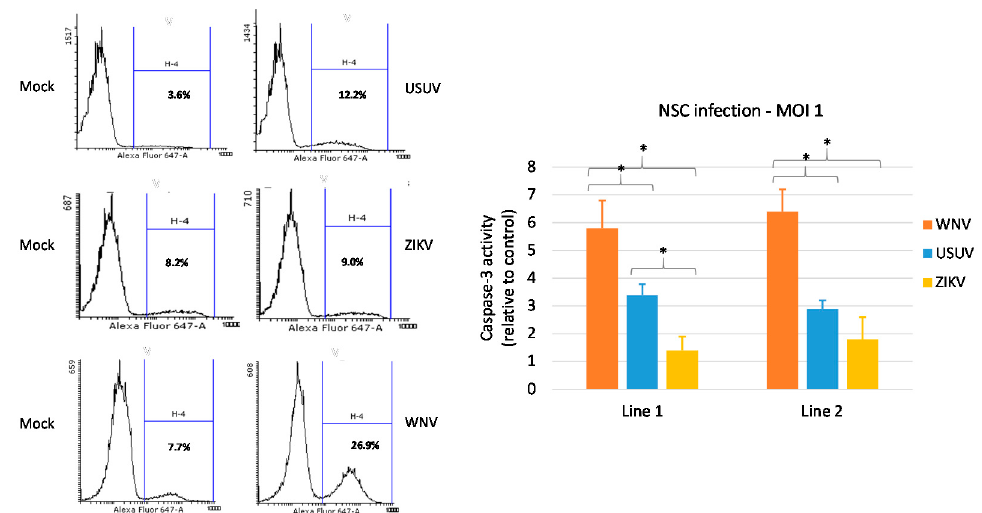
Figure 5. Effect of WNV, USUV and ZIKV infection on NSC apoptosis. Activated-caspase-3 was measured by flow cytometry in cells collected at 4 days post infection with WNV lineage 2, USUV Europe 1 and ZIKV Asian lineage at MOI 1. Flow cytometry data show representative experiments (infected cells are shown in the right panel and the respective mock infection control in the left panel). The experiments with the three viruses were performed independently at different times and a mock infection control was included in each experiment. Mean ± SD of caspase activity at 4 dpi of duplicate samples in triplicate experiments is reported in the graph. * p < 0.05, Student’s t-test.